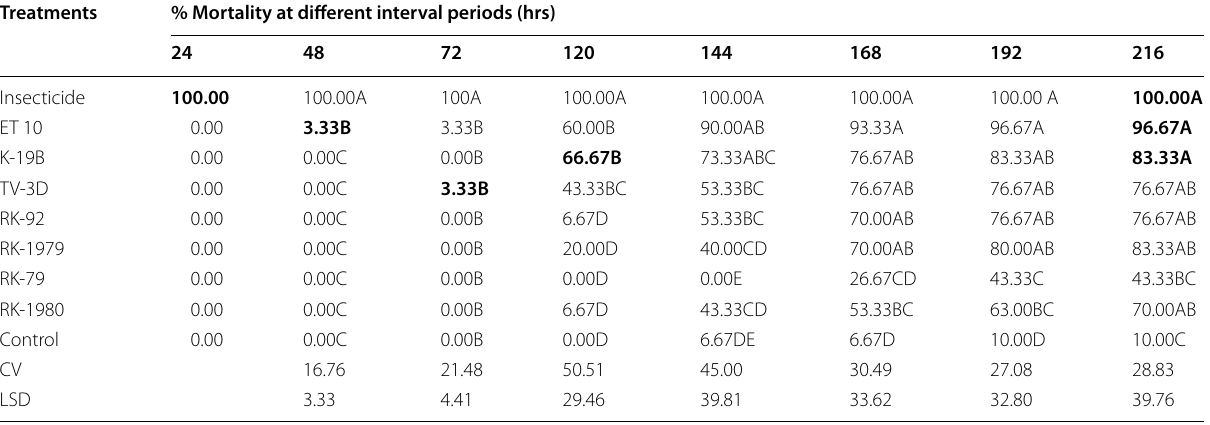
The highest measurement values obtained according to the observation time are highlighted in bold